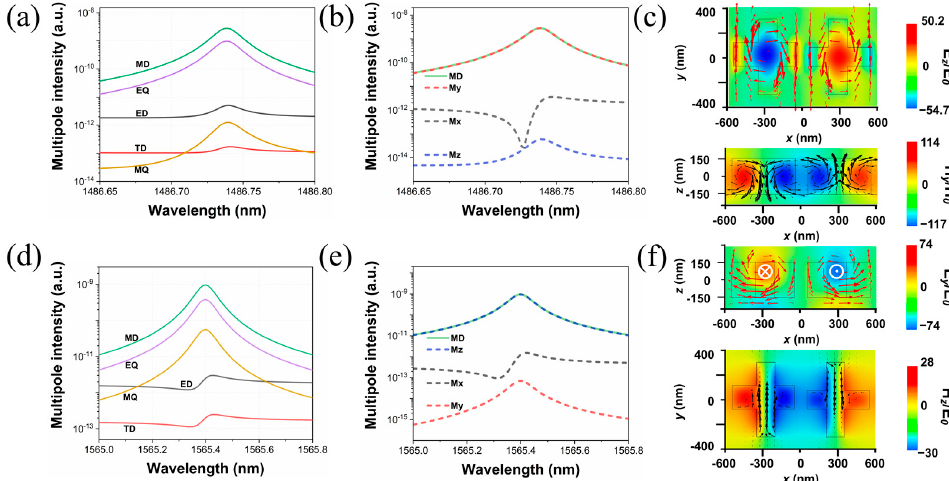
Figure 7. The calculated multipole intensity for modes III ( a ) and IV ( d ) around resonant wavelengths when Δ w is 40 nm. The x, y, and z components of MD moments around mode III ( b ) and mode IV ( e ). Electromagnetic field distributions of mode III ( c ) and mode IV ( f ).